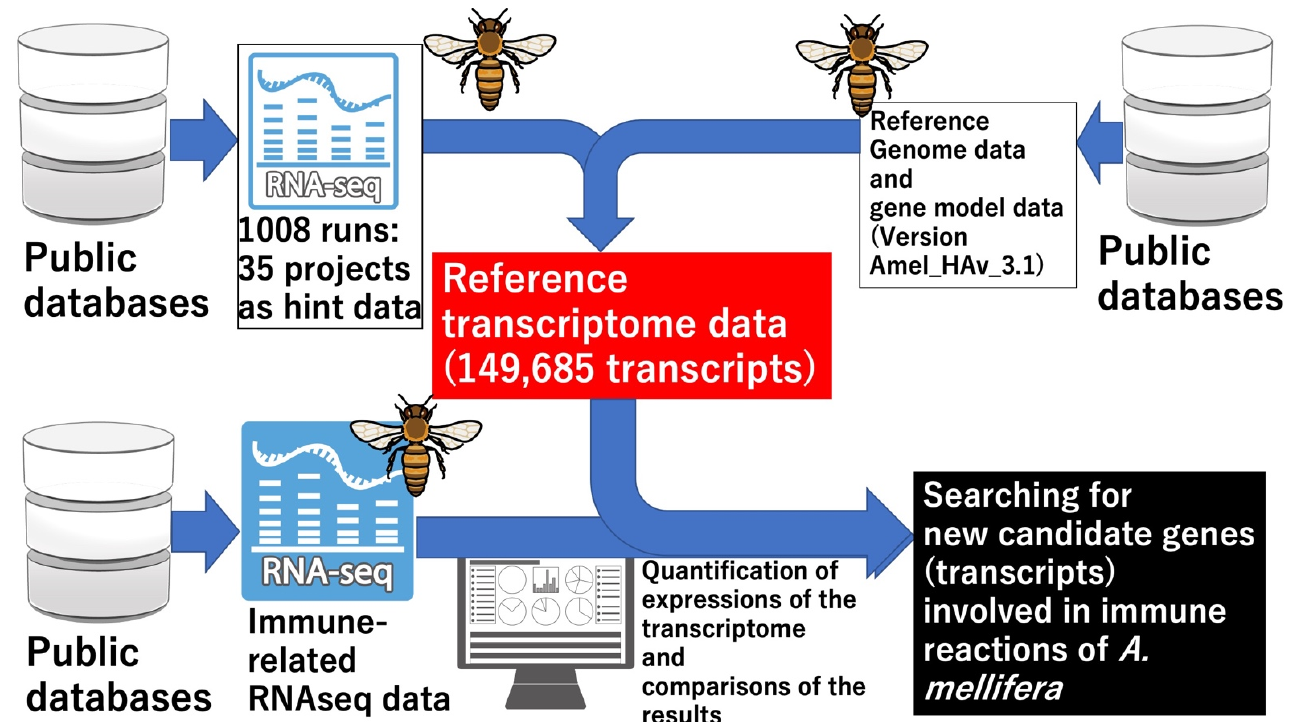
Figure 1. Workflow of the data analyses performed in the present study. To construct the reference transcriptome data, 1008 RNA-Seq data from 35 projects were mapped to the reference genome data used as hint data. The reference transcriptome data were constructed using a combination of refer- ence genome, genome model, and hint data and they were functionally annotated with Fanflow4In- sects [18]. We retrieved and curated immune-response-related RNA-Seq data in the public database to search novel candidate transcripts implicated in these processes. We quantified the expression levels of the RNA-Seq data transcripts using the reference transcriptome data. We searched for new candidate transcripts by comparing the expression data. Images were obtained from TogoTV (© 2022 DBCLS TogoTV).